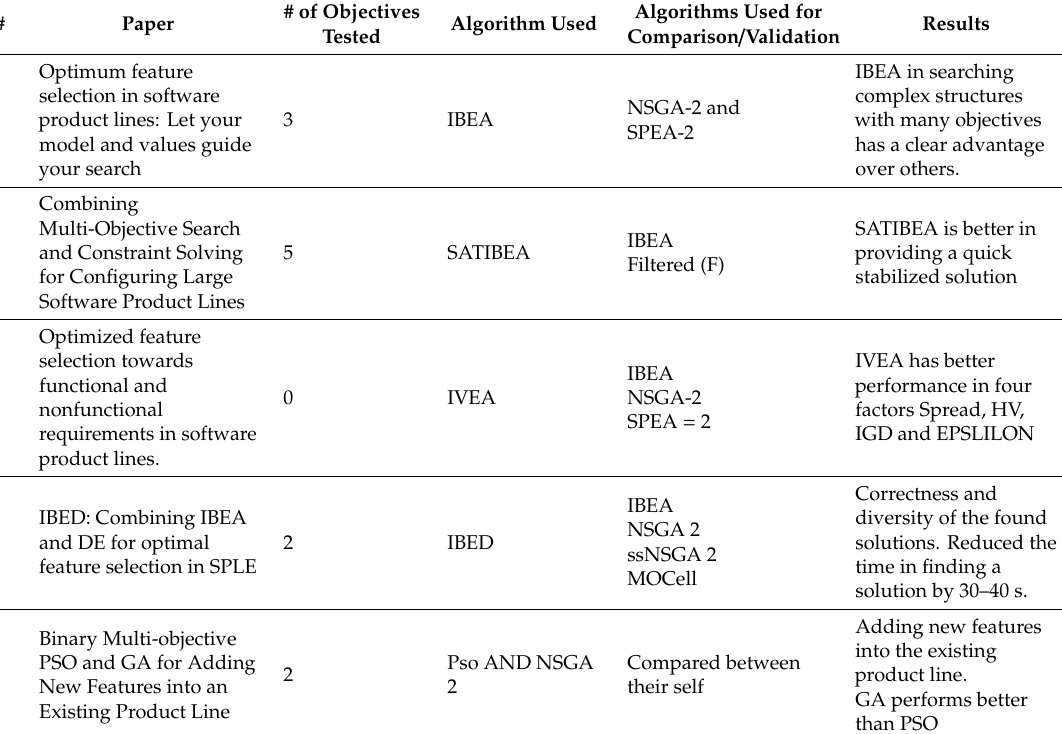
Table 2. Comparison of MOO (Multi-Objective Optimization)